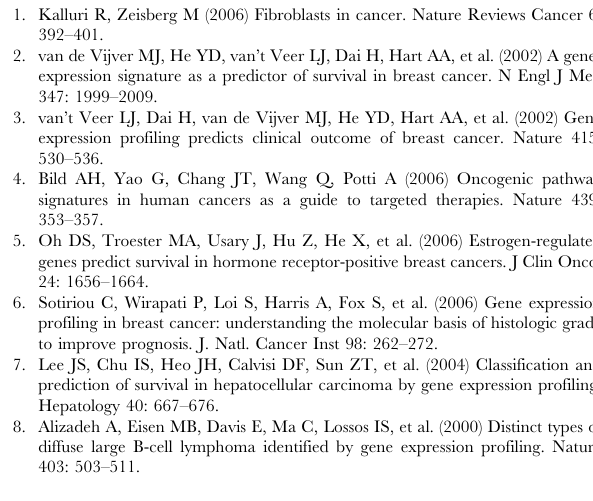
Table S2 Summary of the class prediction results for NKI training set. Genes significantly different between the classes at 0.001 significance level were used for class prediction. 4160 genes were selected as a classifier for Good vs. Bad group and 1651 genes were selected as a classifier for BEST prognosis group. For the prediction of WORST prognosis group 4700 genes were selected as a classifier. Leave-one-out cross-validation method was used to compute misclassification rate based on 100 random permuta- tions. Table S3 Cox univariate and multivariate analysis of risk factors for death. Parameters showing significance in the Cox pro- portional hazard model are shown in bold. Age is categorized into two groups based on . 45 years old or not. Lymph node status is categorized into two groups, one with one or more tumor cells infiltrated into the lymph node and another group with no tumor cells infiltrated into the lymph node. P value for statistical significance was calculated by log-rank test. T1T2 is categorized based on the diameter of tumor size are . 2 cm or